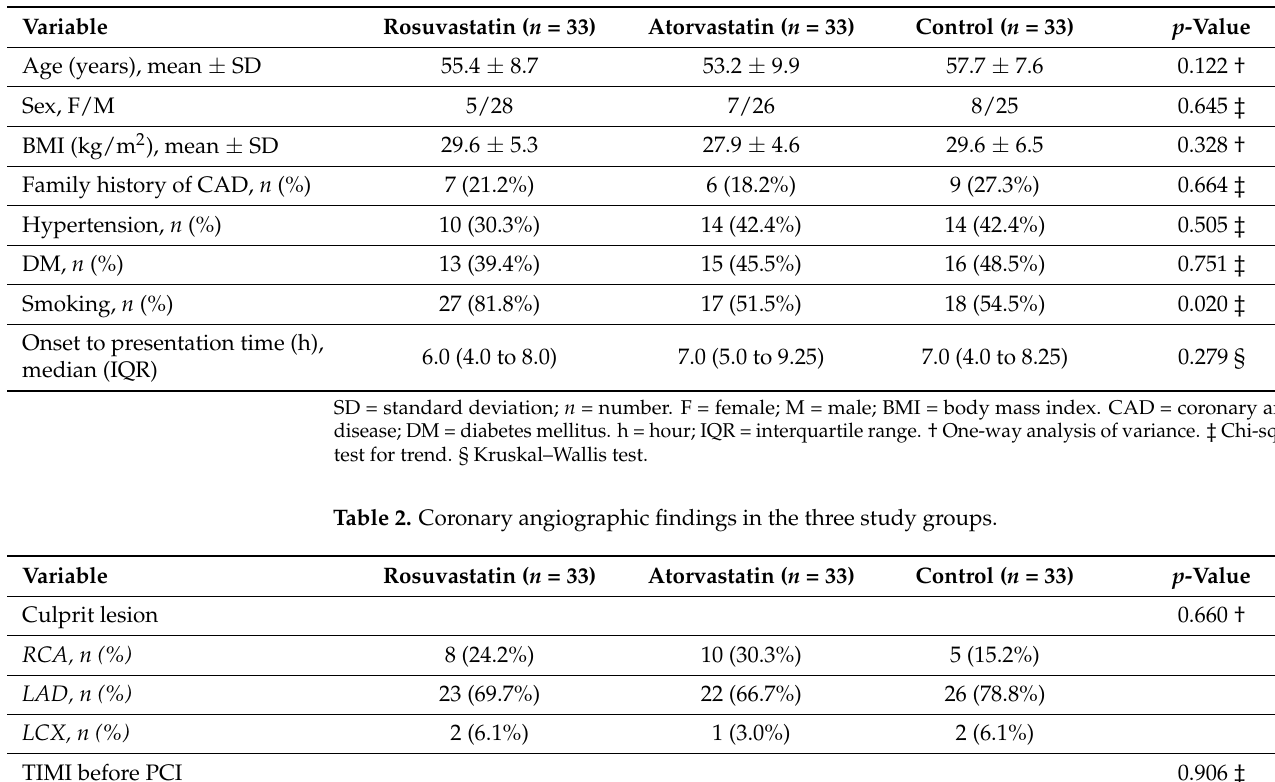
Table 1. Baseline characteristics of the three study groups.